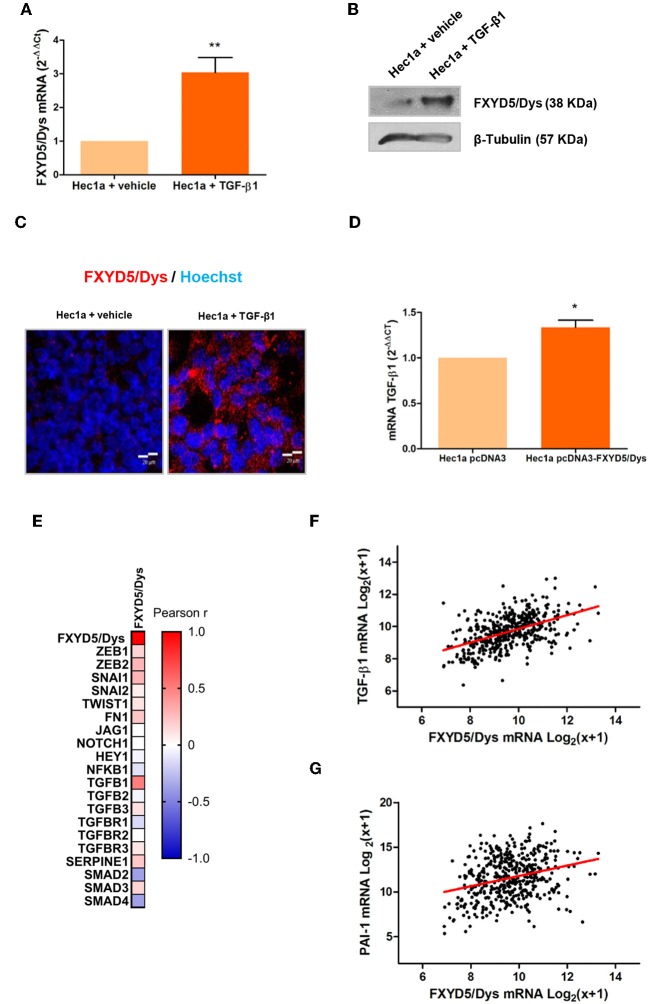
Association between TGF-β1 and FXYD5/Dys expression. (A) RT-qPCR analysis of FXYD5/Dys expression in Hec1a cells treated with 10 ng/ml TGF-β1 for 24 h. Controls were incubated with vehicle (**P < 0.01, Wilcoxon signed rank test). (B) Western immunoblotting of Hec1a protein extracts using FXYD5/Dys monoclonal antibody (sc-166782; 2 μg/ml). β-Tubulin was included as loading control (monoclonal antibody D66; 0.5 μg/ml). (C) Representative images of fluorescent immunocytochemistry analysis of FXYD5/Dys protein expression (anti-FXYD5/Dys polyclonal sc-98246; 2 μg/ml); cell nuclei were stained with HOECHST 33342, bar: 20 μm. (D) RT-qPCR analysis of TGF-β1 mRNA levels in Hec1a pcDNA3-FXYD5/Dys and Hec1a pcDNA3 cells (*P < 0.05, Wilcoxon signed rank test). (E) Correlation analysis between FXYD5/Dys and TGF-β pathway-related genes. A heatmap was built based on Pearson r correlation values for each gene. (F) Correlation analysis between TGF-β1 and FXYD5/Dys mRNA levels in EC samples from the TCGA-UCEC cohort (Pearson correlation, r = 0.4966, N = 444). mRNA levels are expressed as log2(x + 1) were x is the RSEM normalized expression value. (G) Correlation analysis between PAI-1 and FXYD5/Dys mRNA levels in EC samples from the TCGA-UCEC cohort (Pearson correlation, r = 0.2886, N = 444). mRNA levels are expressed as log2(x + 1) were x is the RSEM normalized expression value.